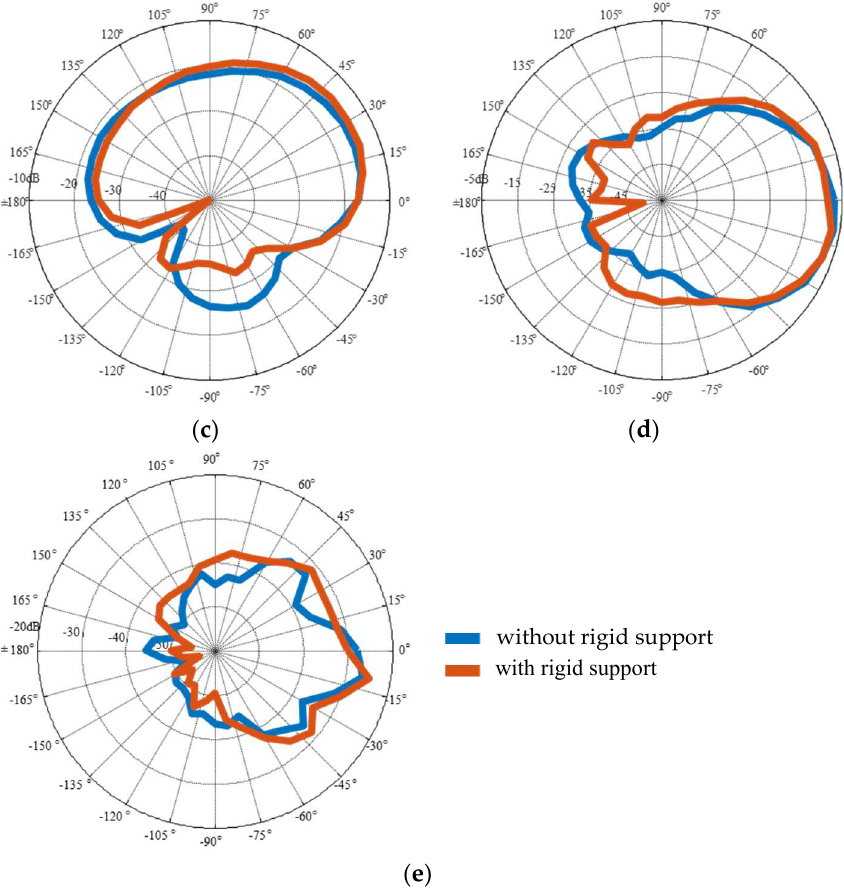
Figure 11. Comparing directivity patterns, with and without a rigid back support: ( a ) 500 Hz; ( b ) 1 kHz; ( c ) 2 kHz; ( d ) 4 kHz; and ( e ) 8 kHz.